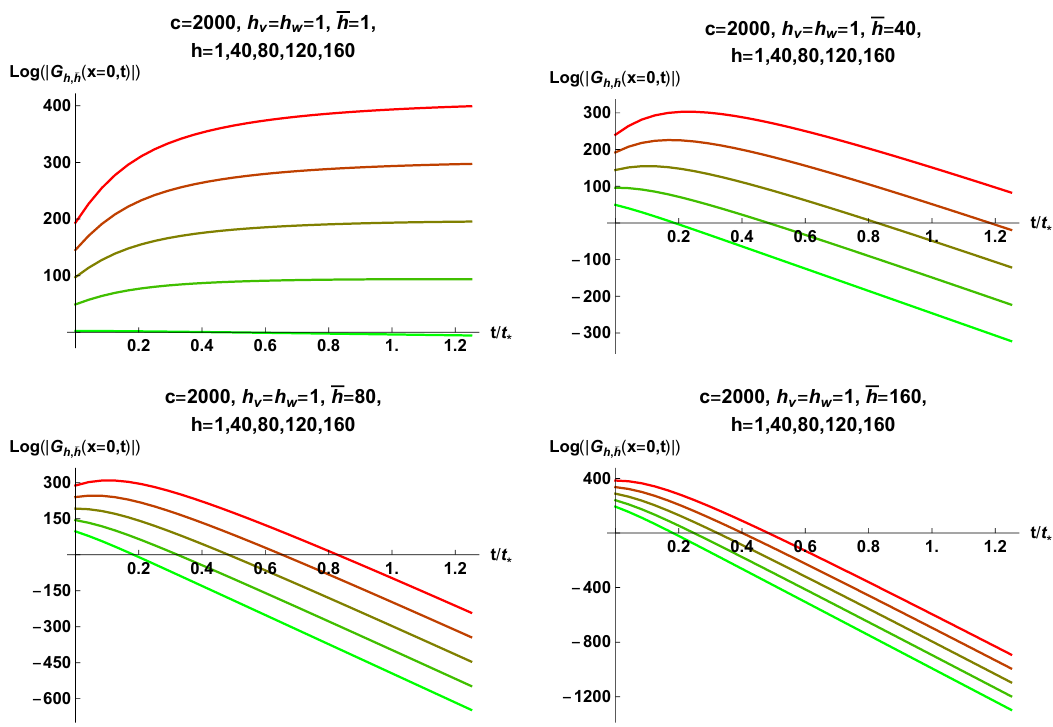
Figure 3 . The logarithm of the ratio of the non-vacuum and vacuum blocks G at x = 0 as a function of t with (cid:12) = 1 and ( (cid:15) 1 ; (cid:15) 2 ; (cid:15) 3 ; (cid:15) 4 ) = of the exchanged operators are shown from green to